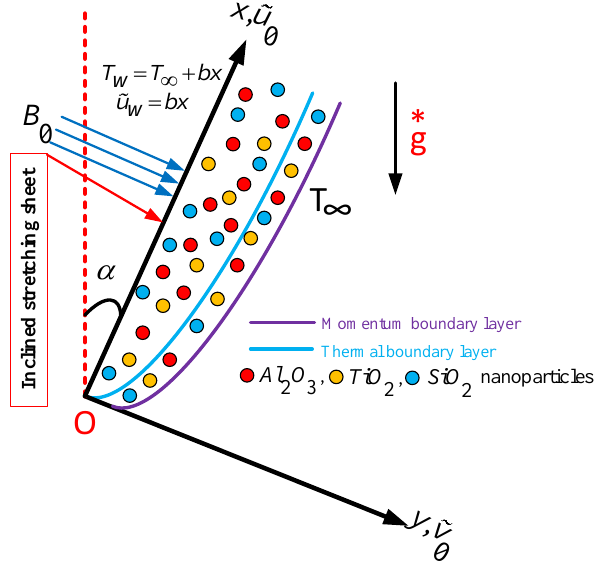
Figure 1. Physical model of developed trihybrid nanofluid